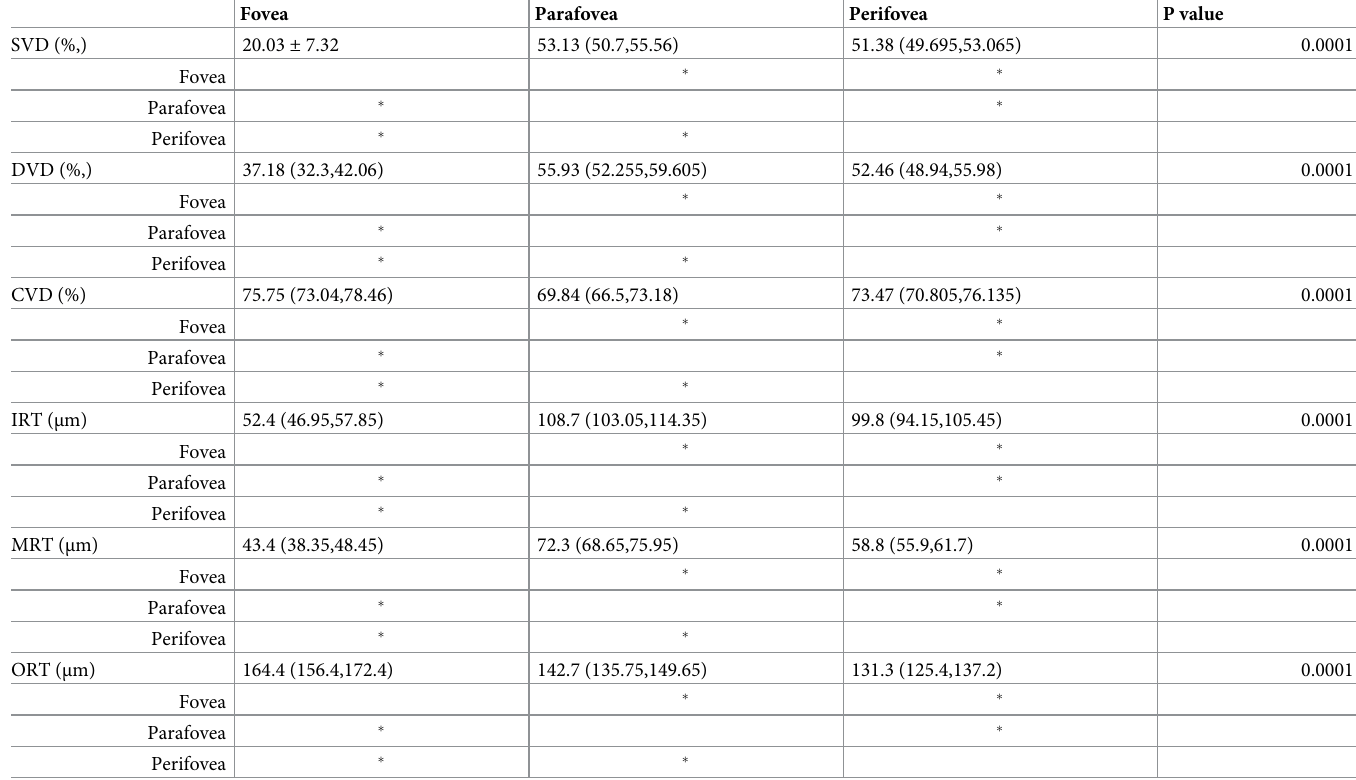
Table 1. OCT and OCTA characteristics of the subjects in central 6 mm diameter circle of macula. Fovea Parafovea Perifovea P